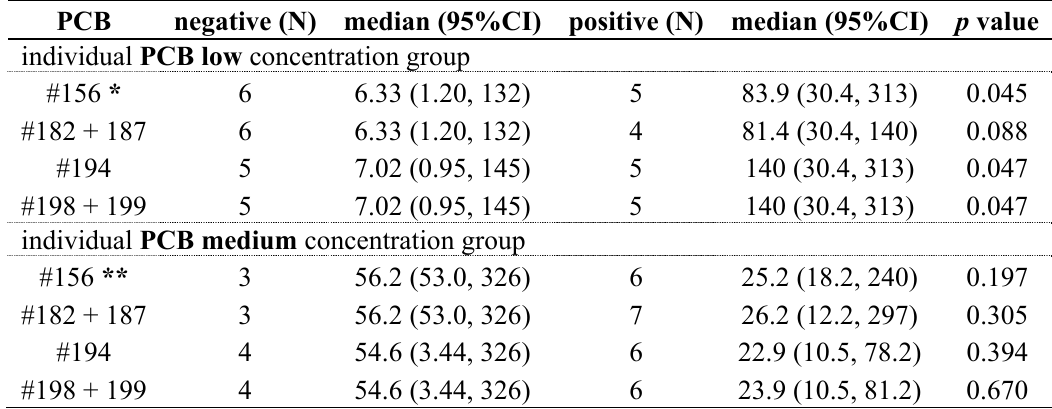
Table 5. Association between egg specific IgE and IL-22 by individual PCBs concentration